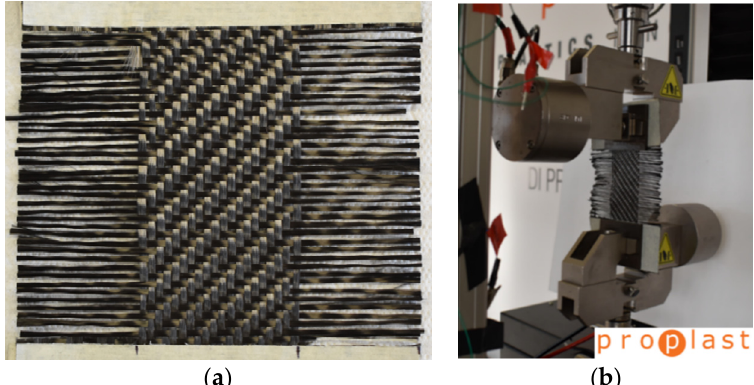
Figure 4. Detail of CF Specimen ( a ) and experimental setup ( b ) for Tensile test on Dry fabric for Intra-ply evaluation.